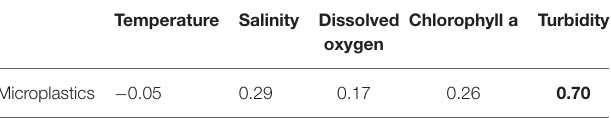
TABLE 2 | Pearson correlation coefficients among different water parameters and microplastics in the near-bottom layer of the Baltic sea (significant correlation is given in